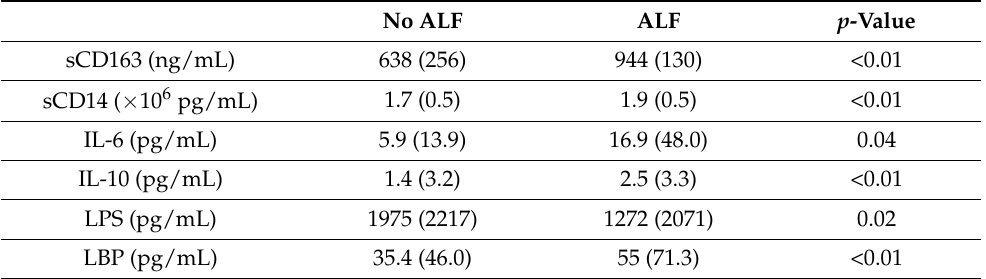
Table 2. Mean plasma marker values stratified by the presence of advanced liver